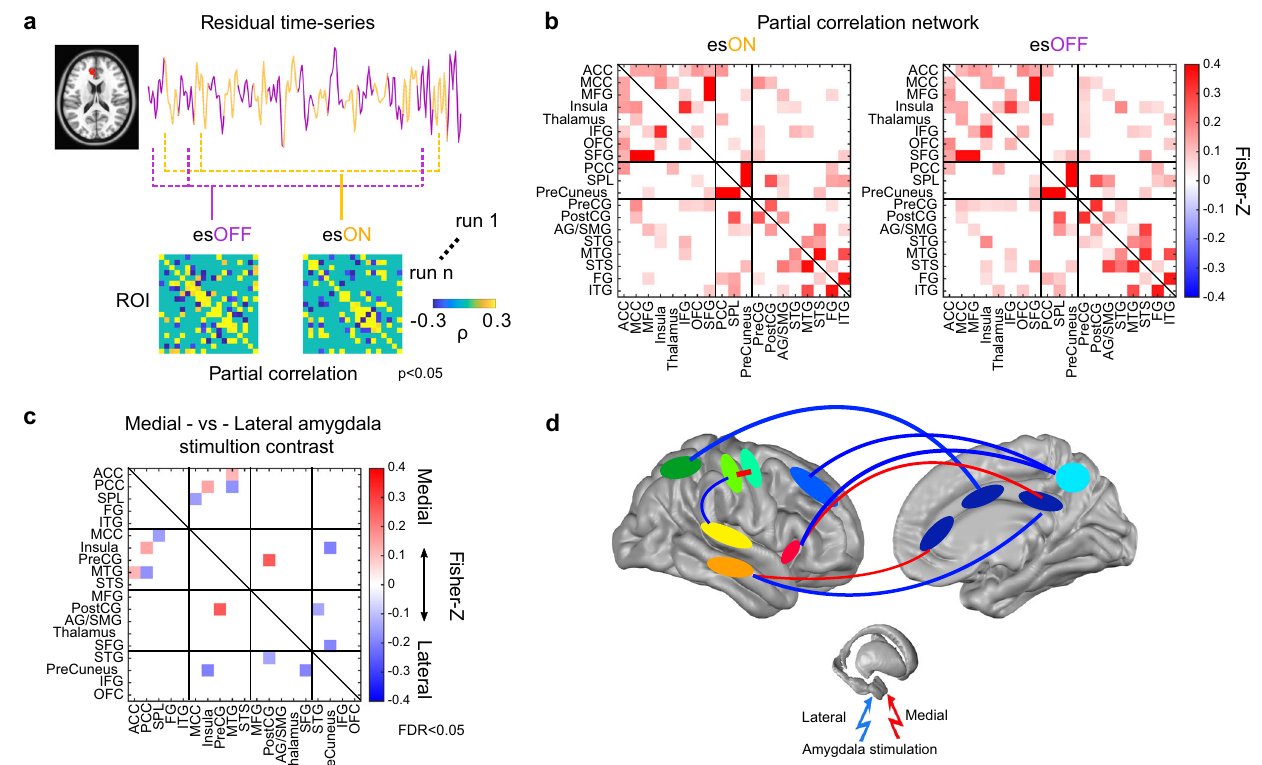
Fig. 7 | Second-order connectivity analysis on the es-fMRI residual time series. a Procedureto compute the connectivitywithinelectricalstimulation (es-) ON and OFF period. Red patch on the MRI image shows the location of a ROI for example. Average residual time series within the ROI is shown in yellow (esON) and purple (esOFF) time series plotted on the right. Example partial correlations ( ρ ) among ROIs were shown below separately for es-ON and es-OFF period (thresholded at P <0.05, two-sided t -test, uncorrected). b Overall averaged partial correlation networkswereshownfores-ONandes-OFFperiod.ColorindicatesFisher-Zvalues. The community parcellation (indicated with black lines) was derived with Leiden algorithm. For negative correlation network, see Supplementary Fig. 5. c Contrast of partial correlation in the es-ON period between medial and lateral amygdala subdivision stimulation (thresholdedatFDR<0.05, two-sided t -test).Hot and cold colorsindicateconnectionislargerformedialamygdalastimulationandviceversa.